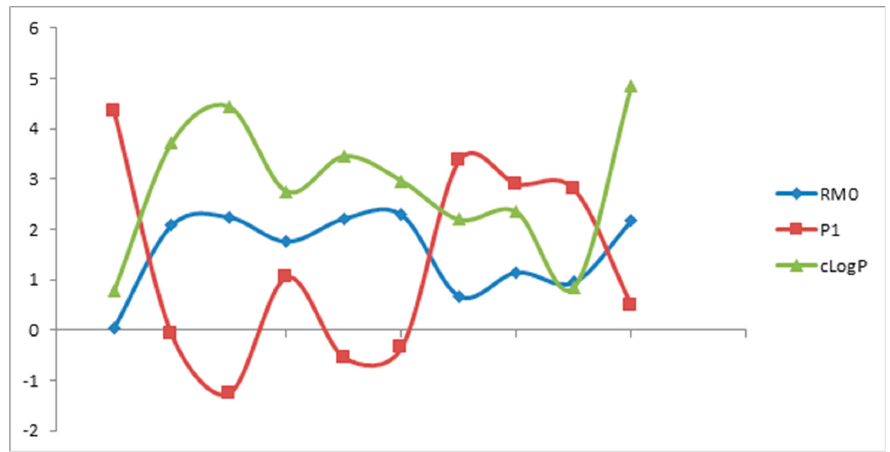
Figure 1. The relationship between experimental lipophilicity indices ( R M0 , P 1 ) and computed cLogP values.